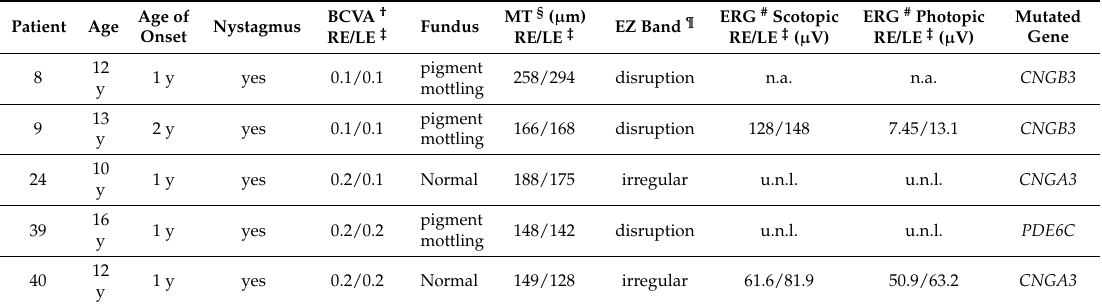
Table 4. Clinical and molecular data of Achromatopsia